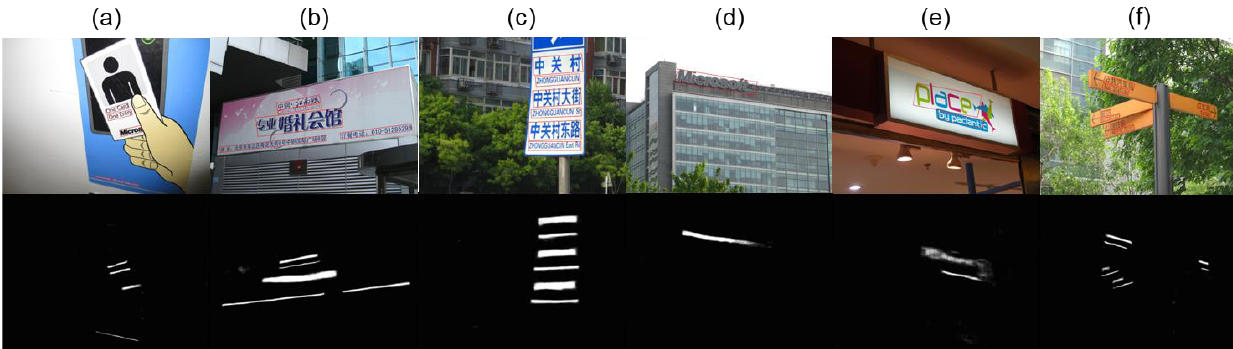
Figure 4. Visualization results. ( a , b ) are scene text detection under multi-scale variation, with significant variations in text size and stroke thickness in the same image. ( c ) is scene text detection of adjacent texts. ( d ) is scene text detection where the text is easily confused with the background. ( e ) is scene text detection of abstract art texts. ( f ) is scene text detection of multi-directional texts.